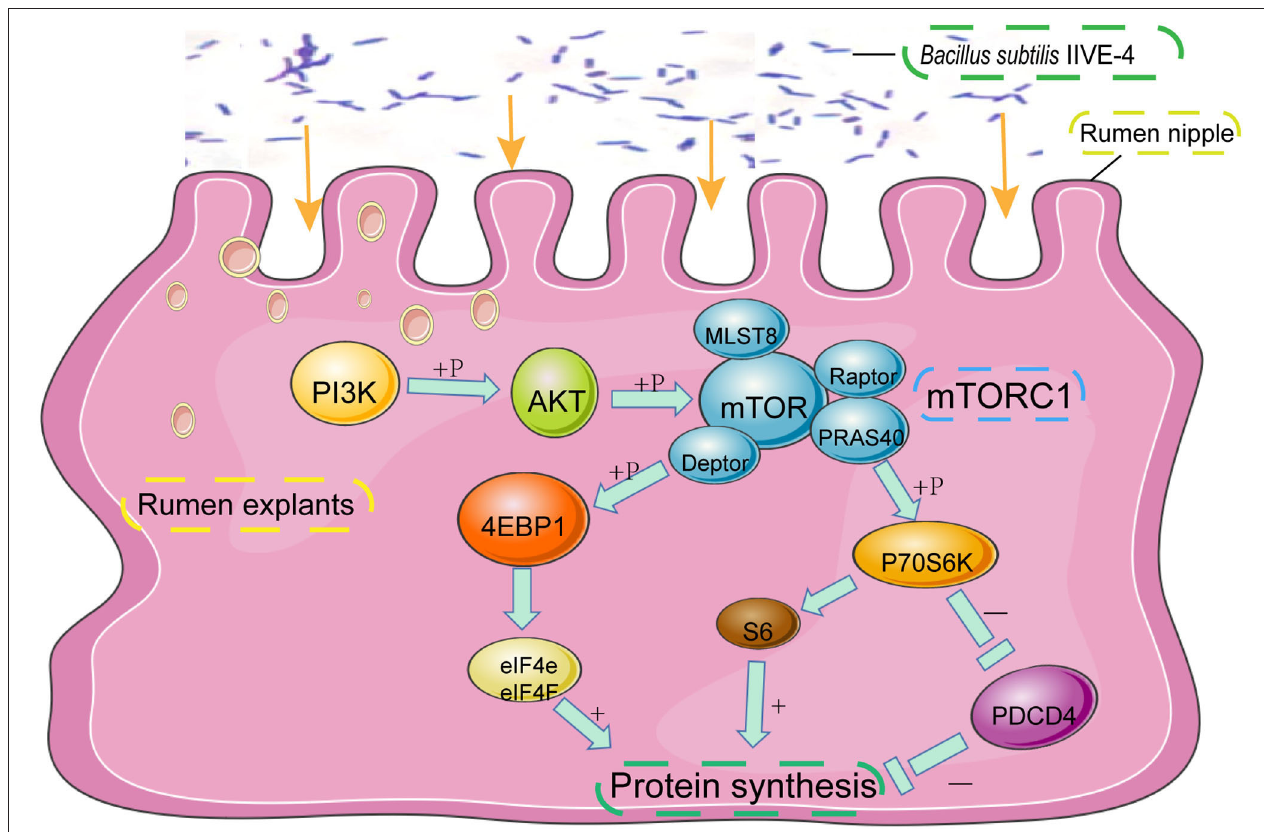
FIGURE 2 | The protective mechanism of Bacillus subtilis can promote protein synthesis in rumen explants by the PIK3CB-AKT-mTORC1 pathway. In the rumen of Holstein cows, Bacillus subtilis IIIVE-4 was able to secrete nutrients (methionine, leucine, etc.) to enhance protein synthesis by acting on the PIK3CB-AKT-mTORC1 signaling pathway and increasing the expression levels of 4EBP1 and P70S6K